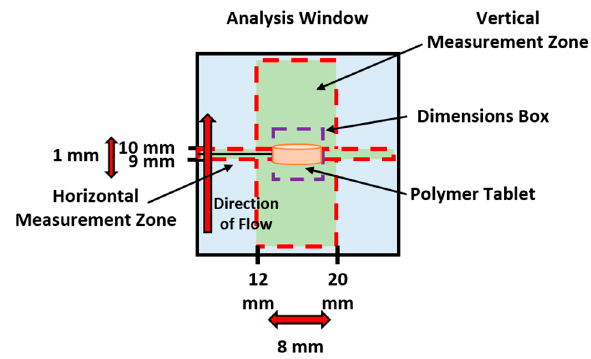
Figure 2. A schematic representation of the analysis conducted on the polymer compacts, displaying the measurement zones and the tablet orientation.